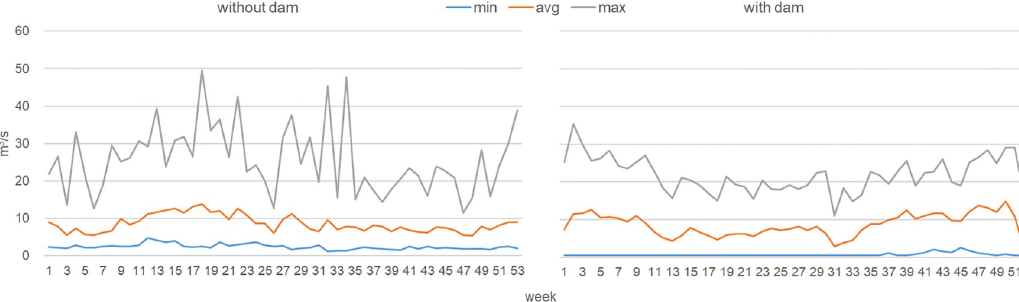
Fig 4. Natural flow variation vs. market driven variation. Based on average weekly flow volumes. The variation of the natural system represents the period 1993 to 2015. The variation of the market driven system is derived by combining the natural inflows from the period 1993 to 2015 with the market price variation in the period 2001 to 2015 (i.e. a matrix of 345 flow/price-year